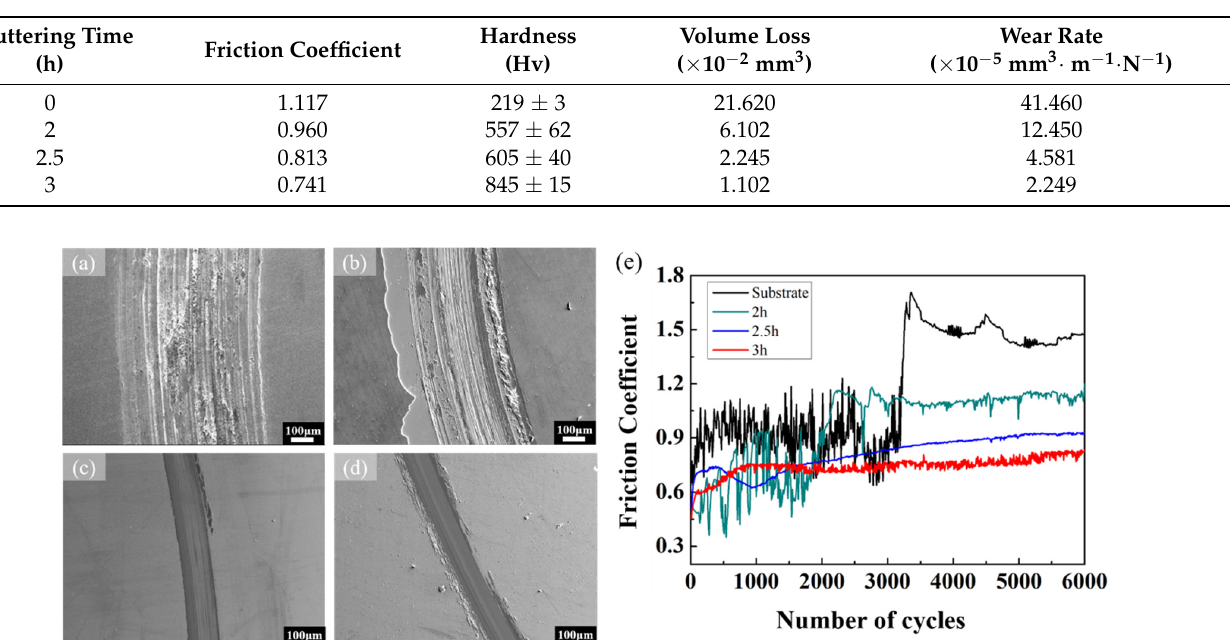
Figure 9. SEM observation for over-view of the wear track (sliding speed 0.2 m·s − 1 and load 2 N) on MEA substrate with ( a ) bared surface and CrN films deposited for ( b ) 2 h, ( c ) 2.5 h, and ( d ) 3 h respectively, and ( e ) Friction coefficient versus the number of cycles at different sputtering times. Table 4. Wear track width, and wear depth of CoCrNiSi0.3 MEA without and with CrN films de- posited at different times.